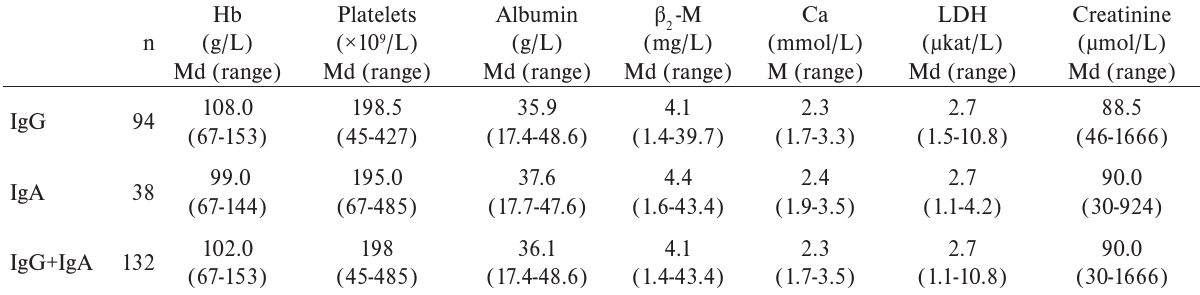
Table 2. Median levels and range of selected laboratory parameters in groups of IgG, IgA and IgG plus IgA patients with multiple myeloma.